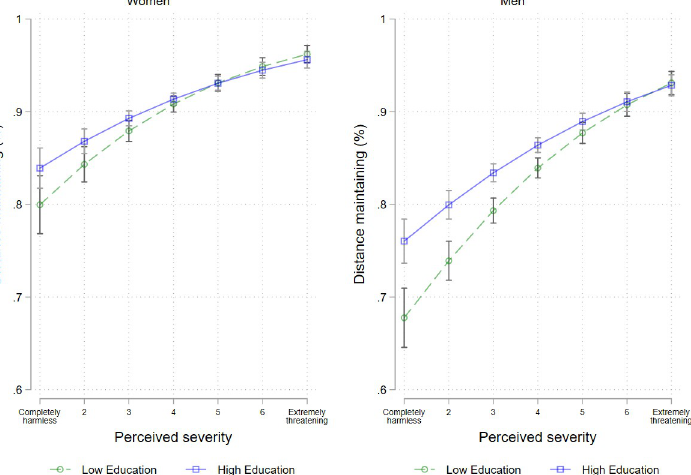
Fig 7. Distance maintaining by severity and education levels among women and men. Logistic regressions with interaction of severity and education level, adjusted for age group, repeat respondent, community size, and federal state, calendar